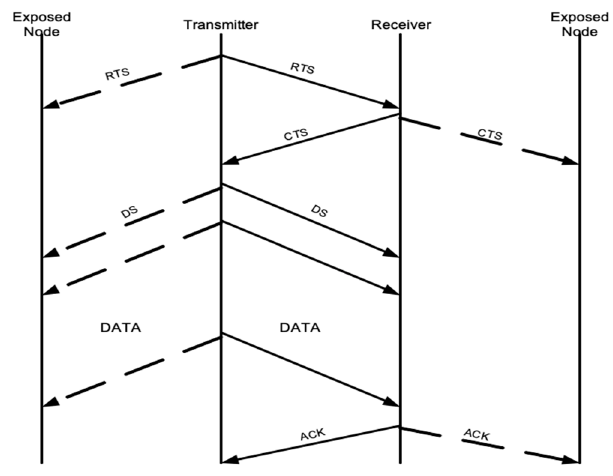
Figure 4. Exposed Node Solution in Multiple Access Collision Avoidance for Wireless